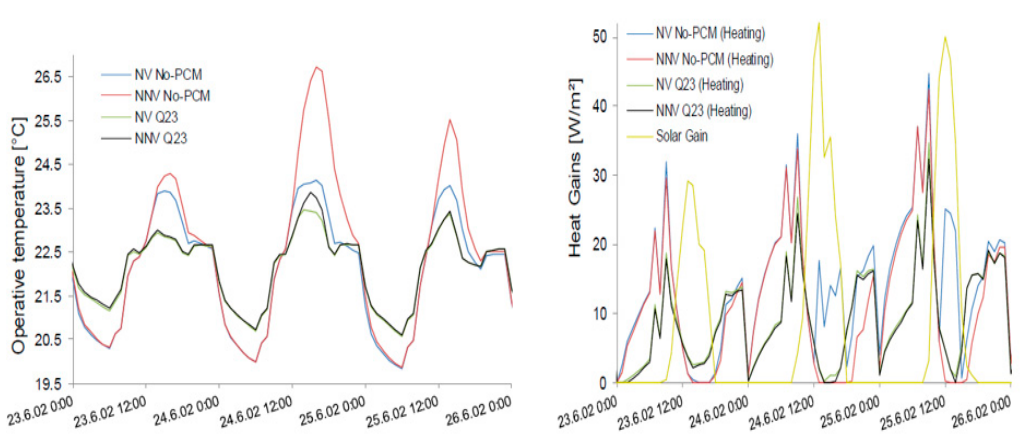
Figure 11. Operative temperature ( left ) and heat gains ( right ) for winter days 23–25 June (building A, Seq. 4).